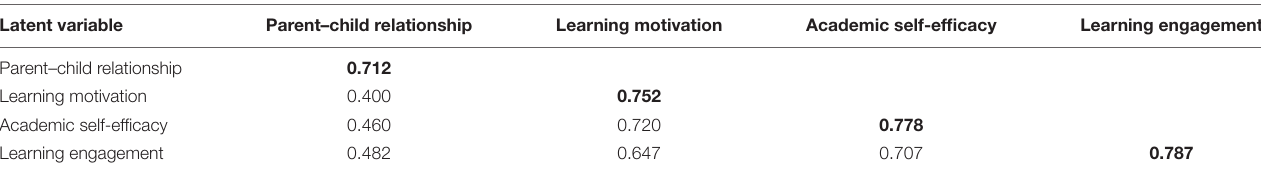
TABLE 3 | The discriminate validity test of latent